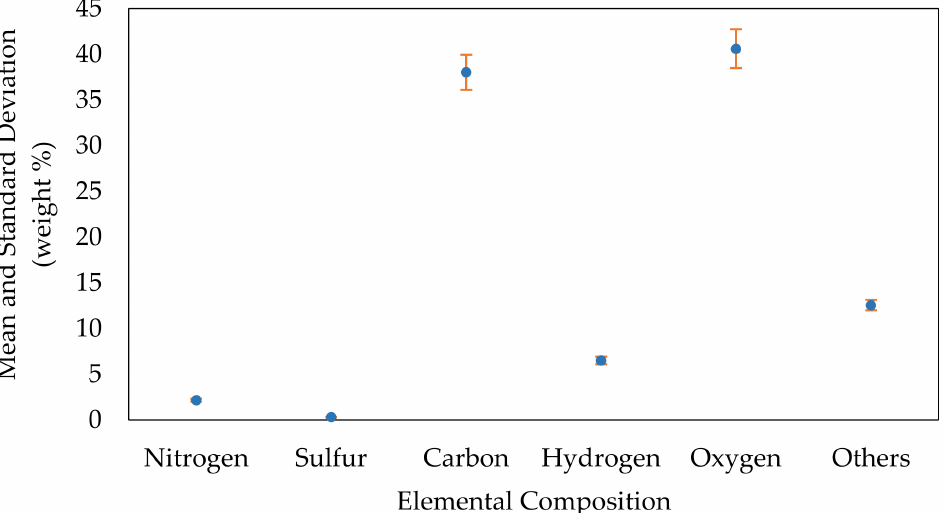
Figure 10. Mean and standard deviation of weight percentages of different elements present in MSW.